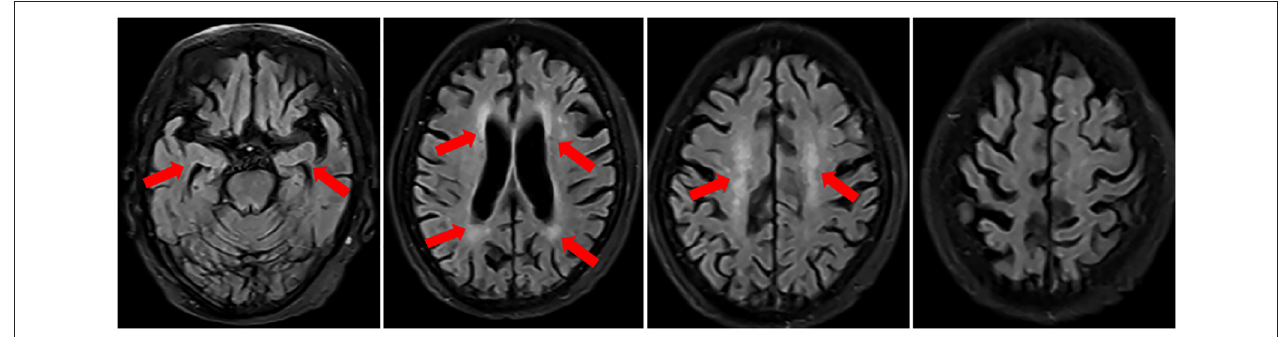
FIGURE 1 | Brain MRI in November 2018 revealed multiple ischemic lesions, white matter degeneration and brain atrophy, including hippocampal atrophy.